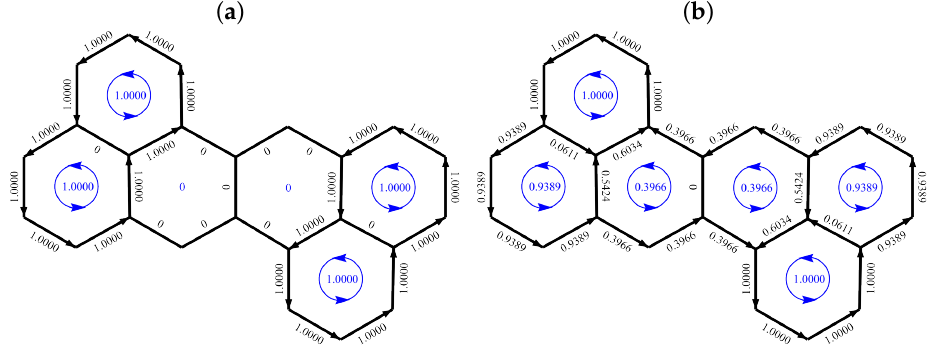
Figure 3. Current maps of zethrene. ( a ) Scaled CC current; ( b ) scaled HL